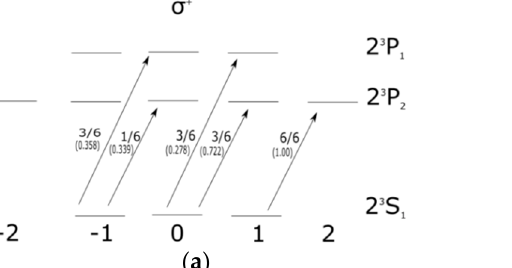
Figure 15. σ + 4 He excitation and relaxation electric dipole matrix elements (0 G, normalized branching ratios labeled on